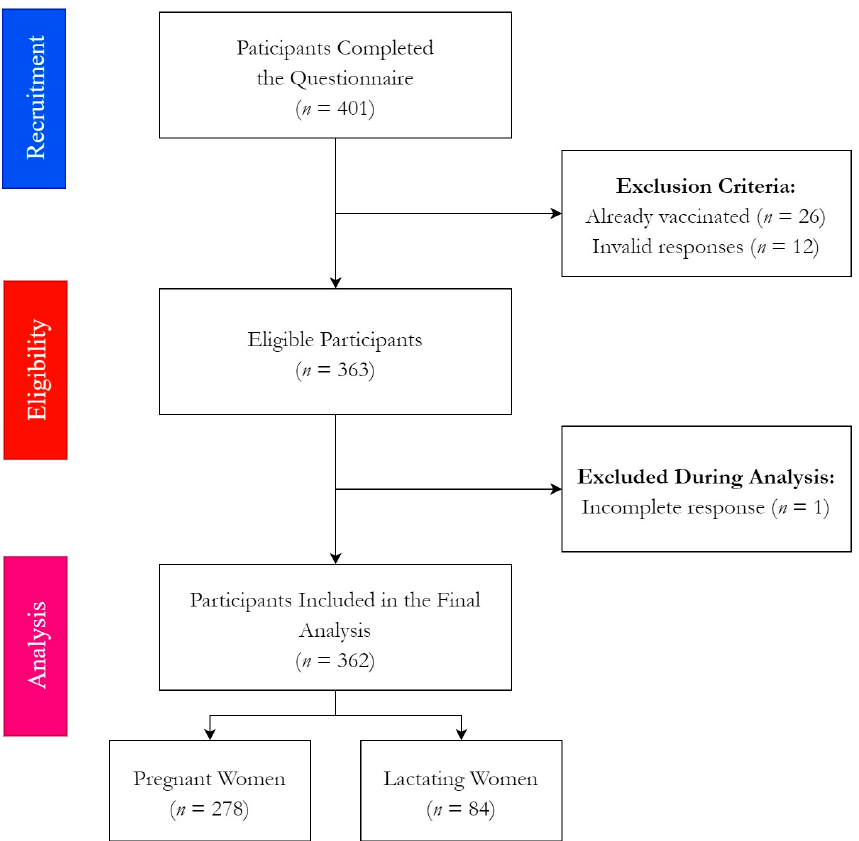
Figure 2. Flow chart of the participating pregnant and lactating women (PLW), University Hospital Brno, August–October 2021 ( n = 362).